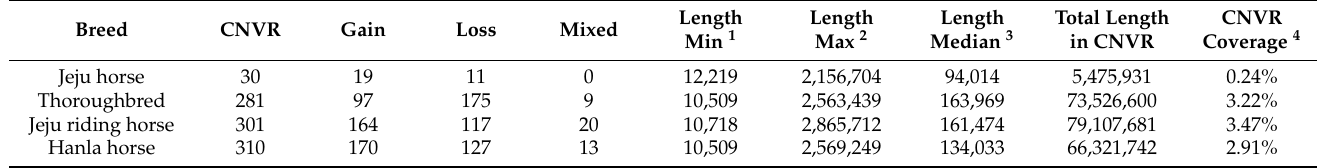
Table 2. The basic statistic of copy number variation regions (CNVRs) of four horse breeds in South